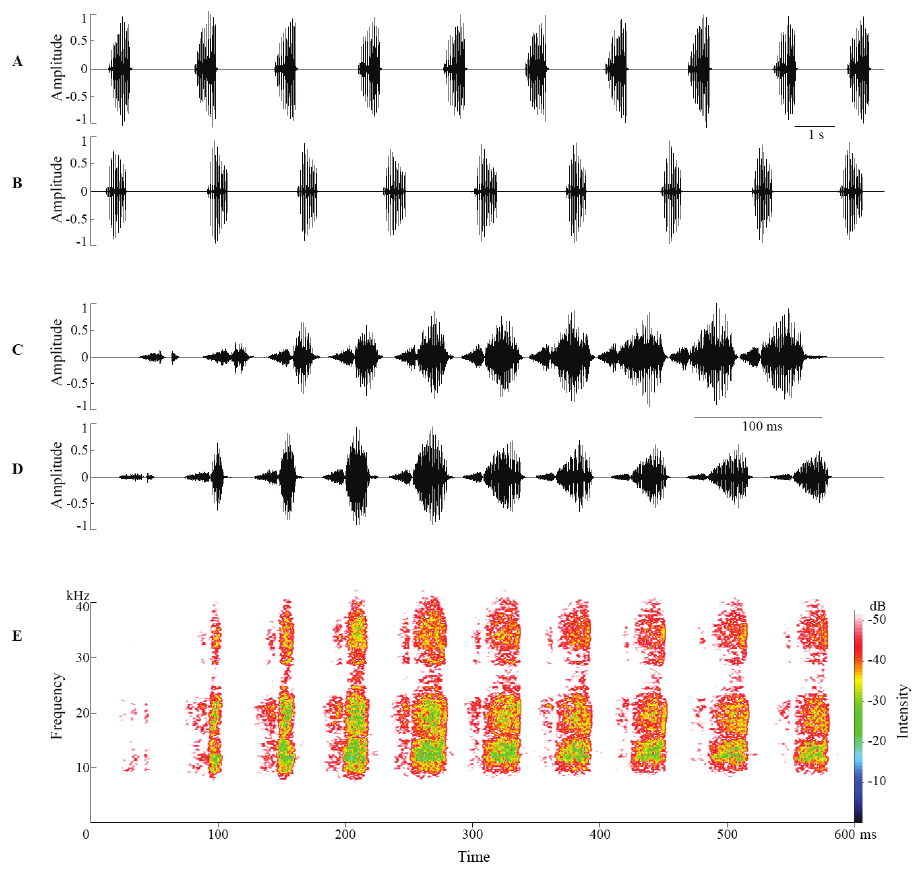
Figure 4. Parapholidoptera castaneoviridis male calling song: A, B oscillographic representation of an echeme sequence C, D detailed echeme E spectrogram (referring to the detailed echeme D ). A, C Bulgaria, Strandzha Mts., Malko Turnovo, 25°C B, D, E Romania, Ciucurova,